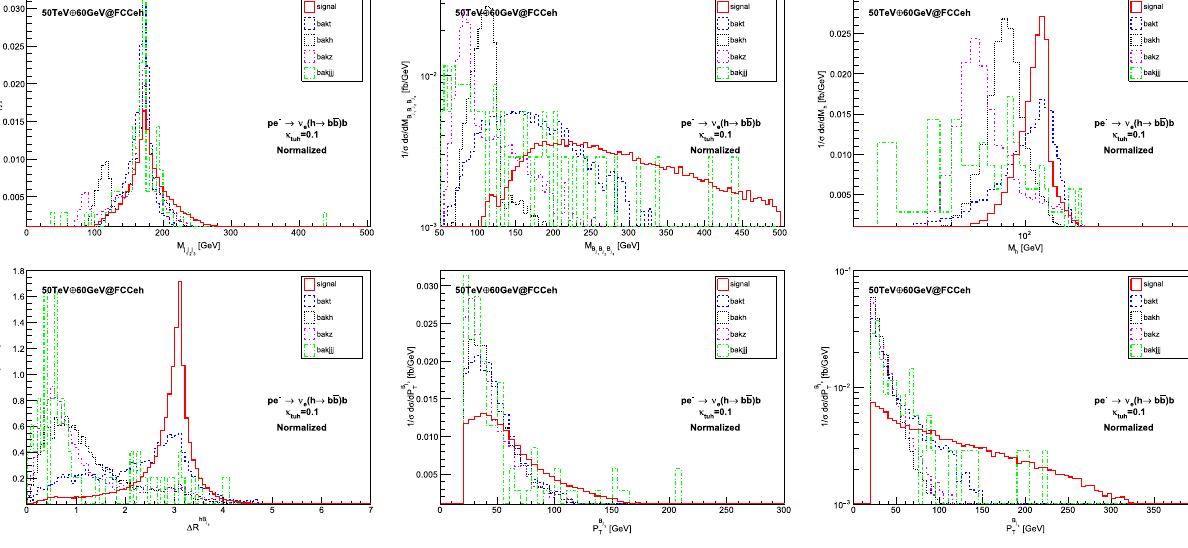
Fig. 5 Various kinematical distributions for signal II and backgrounds at the 50 TeV FCC-eh. The electron beam is 60 GeV. Here κ tuh = 0 . 1. Plots are unit